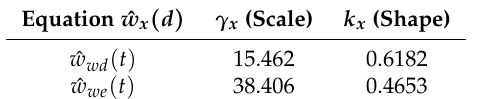
Table 2. Parameters for Weibull distributions.